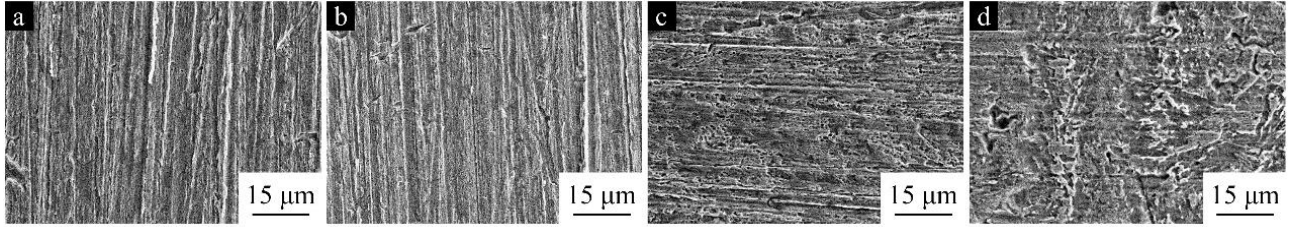
Figure 6. SEM images of EH40 steel with the removal of corrosion products after 14 days of immersion in different systems: ( a ) full system without nitrate addition; ( b ) starvation system without nitrate addition; ( c ) full system with nitrate addition; and ( d ) starvation system with nitrate addition.